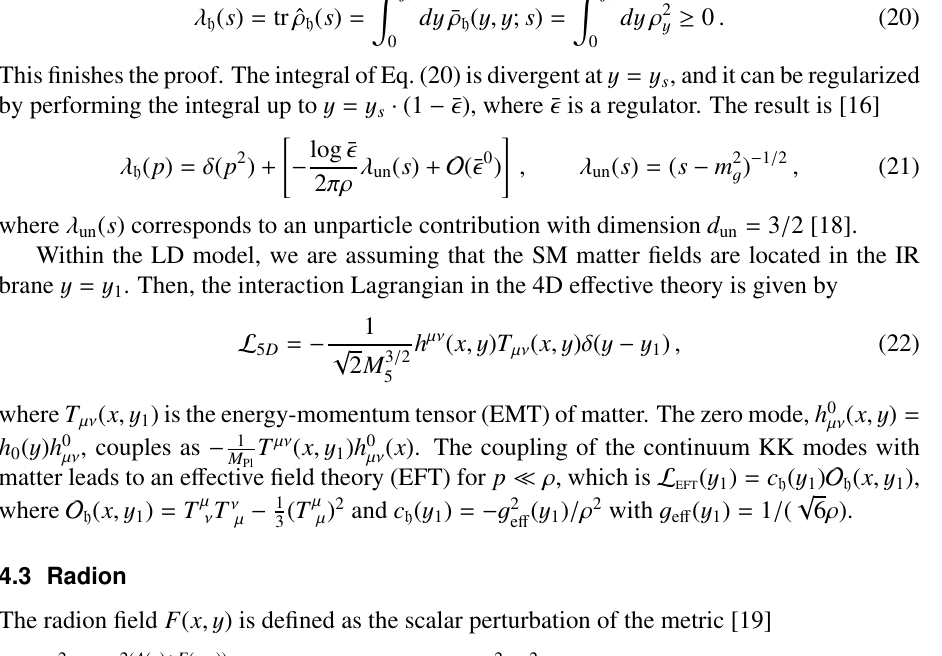
, + ∞ ). Working in the basis g